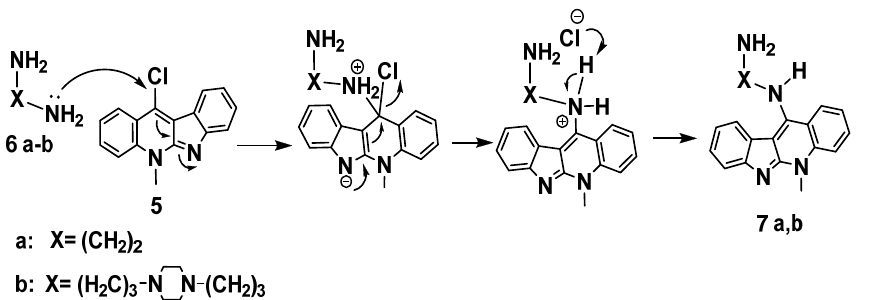
Scheme 6. Proposed mechanism of aromatic nucleophilic substitution for the synthesis of 7a ,